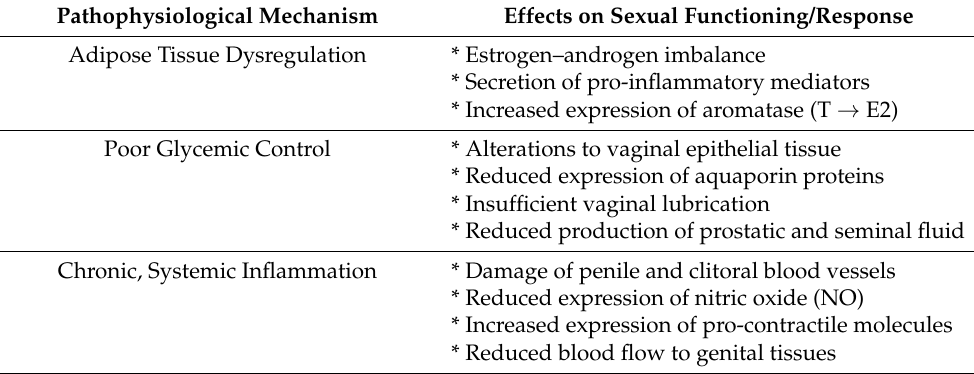
Table 3. The impact of obesity-related mechanisms on sexual